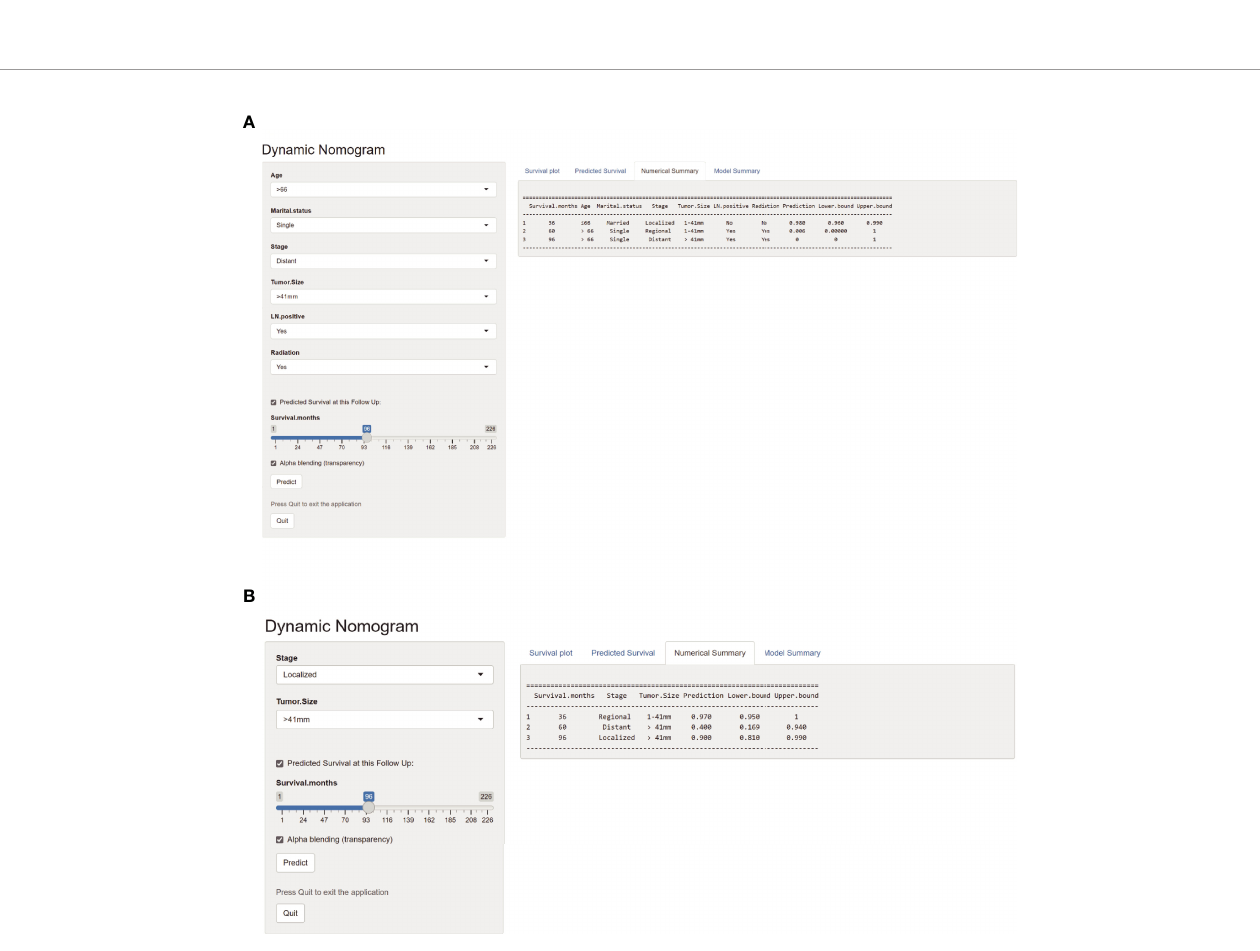
FIGURE 8 | Calibration curves at 3, 5, and 8 years in the training set for validating the cancer-speci fi c survival (CSS) prediction nomogram (A – C) . Decision curve analysis at 3, 5, and 8 years in the training set for the CSS prediction nomogram (D – F) .